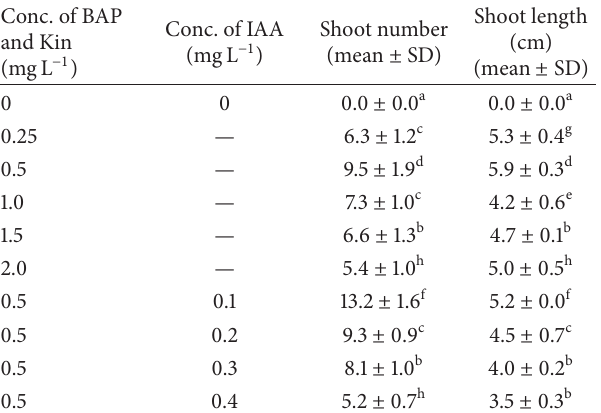
Table 2: Effect of different concentrations of cytokinins (BAP and Kin) combined with IAA on multiplication of